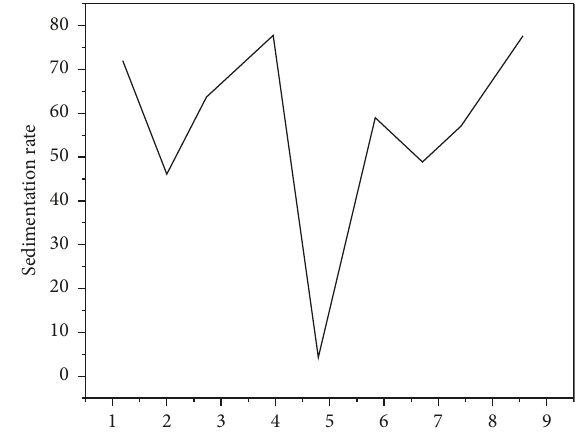
Figure 4: The relationship between the percentage of mass used for titanate coupling agent NDZ--201 and the sedimentation rate.